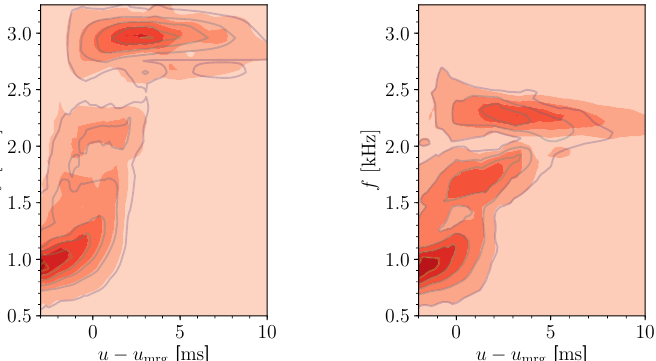
Figure 7. Spectrograms of the GWs for optimally oriented binaries and extracted at r ext = 600 M (cid:12) . The countour lines represent the simulations without NLS. Left panel: SFHo- ν simulation, where the dominant post-merger frequency is 2.95 kHz. Right panel: DD2- ν simulation, where post-merger peak frequency is ≈ 2.4 kHz. Both panels share the same properties as presented in